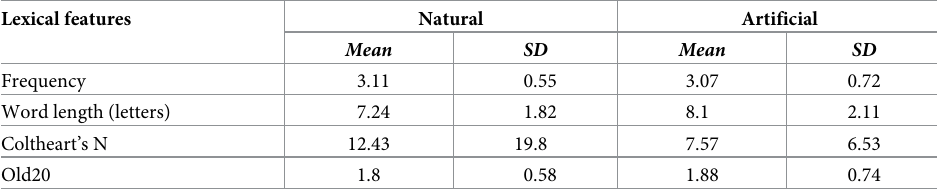
Table 1. Lexical features for each